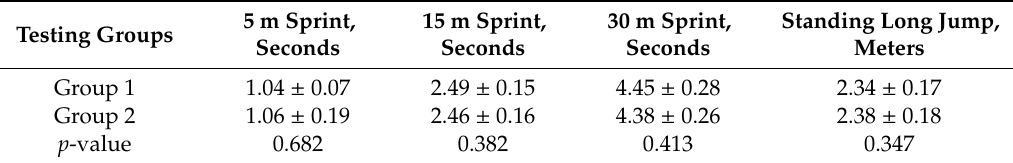
Table 2. Comparison of the results obtained by athletes from groups 1 and 2 in 5, 15, and 30 m sprint tests and the standing long jump test (mean value ± SD). No statistically significant di ff erence between the groups was observed.